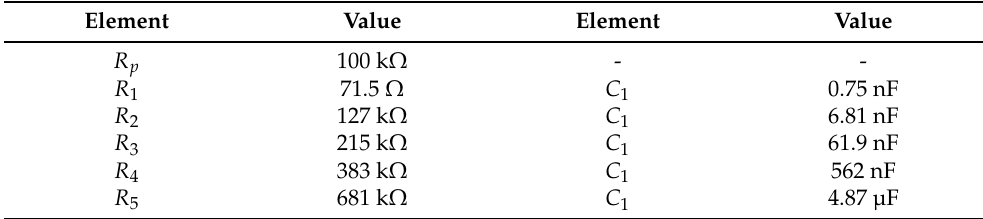
Table 2. Passive elements of a Foster-I network for approximating a fractional-order capacitor with pseudo-capacitance C α =1 µF and order α =